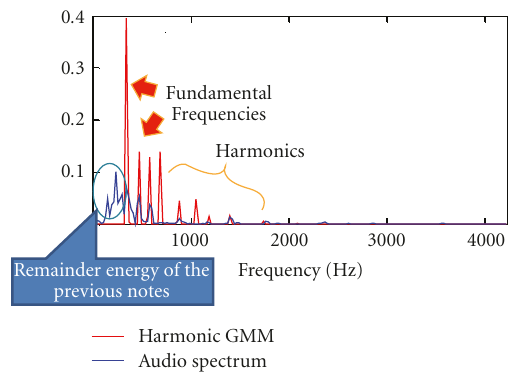
Figure 6: Comparison between harmonic GMM generated by the score and the actual audio